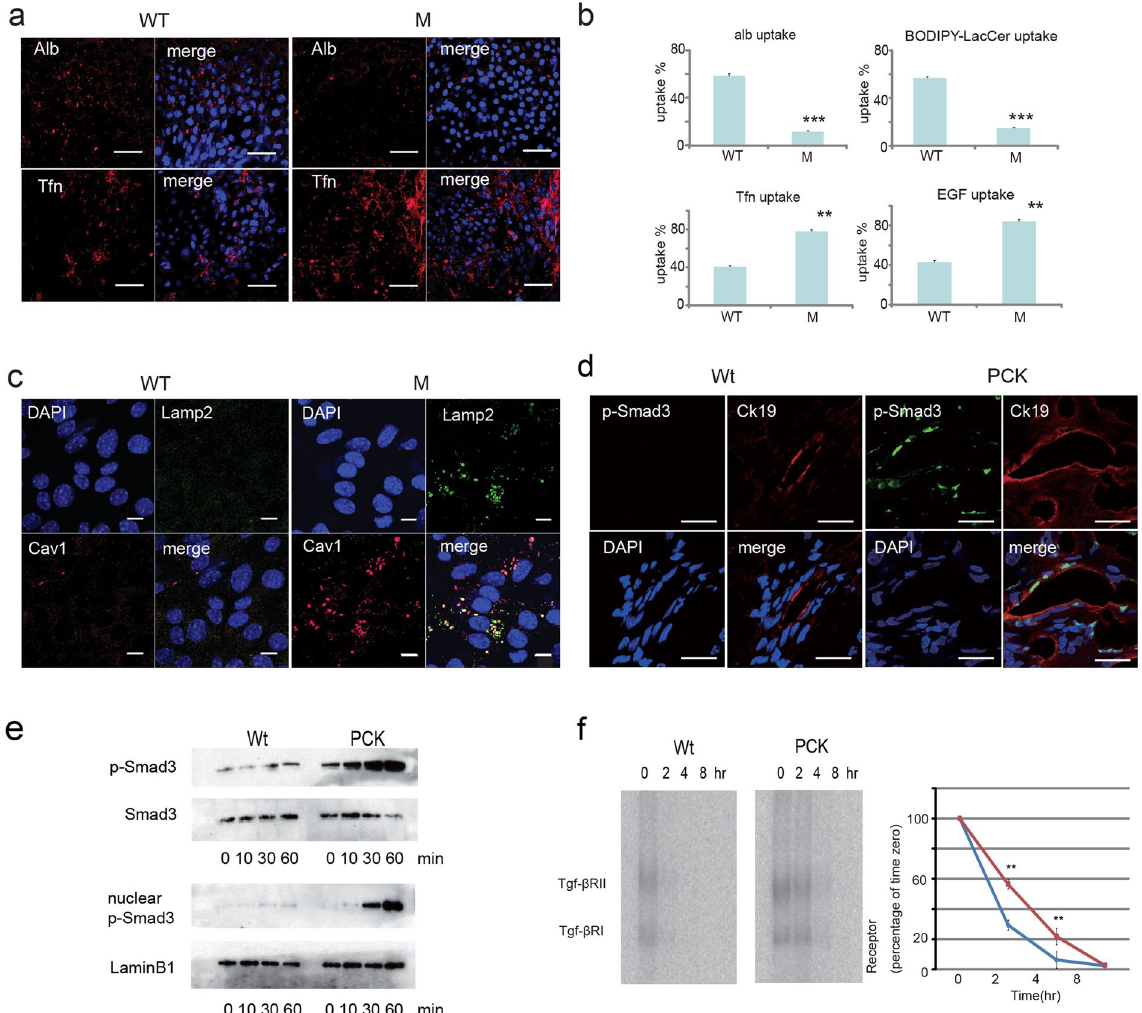
Figure 6. Pkhd1 del3-4/del3-4 collecting duct cells have abnormal endocytosis and membrane protein partition defects. ( a ) Endocytosis assays in primary confluent cultures of collecting duct cells isolated from control (WT) and Pkhd1 del3-4/del3-4 mouse kidneys (M) using fluorescently-labeled markers for the caveolar [albumin (Alb, red)] and clathrin [transferrin (Tfn, red)] endocytic pathways. Nuclei were stained with DAPI. Scale bars, 50 μ m. ( b ) Quantitation of results for internalization assays using fluorescent markers for the clathrin (Tfn, EGF) and caveolar (alb, LacCer) endocytic pathways in confluent primary cultures of collecting duct cells from control (WT) and Pkhd1 del3-4/del3-4 (M) mice. Data were obtained using conventional fluorescence and are expressed as percent of uptake. Data represent quantification of at least 100 cells from each of three independent experiments. ** P < 0.01, *** P < 0.001. ( c ) Primary confluent cultures of collecting duct cells isolated from control (WT) and Pkhd1 del3-4/del3-4 mouse kidneys (M) were stained for markers of lysosomes (Lamp2, green) and caveolin-1 containing lipid-raft rich vesicles [Cav1 (red)] and DAPI (blue). The merged image shows co- localization of caveolin-1 with Lamp2 in large, vacuole-like lysosomes in the mutant cells. Scale bars, 10 μ m. ( d ) Liver specimens of 12-week old Crj:CD/SD (Wt) (control) and PCK rats were stained for phospho-Smad3 (p-Smad 3, red), cytokeratin 19 (Ck19, red) and DAPI (blue). Scale bars, 20 μ m.( e ) Cell lysates of Crj:CD/SD (Wt) (control) and PCK mutant cholangiocyte cell lines treated with TGF- β for the indicated times and fractionated into cytoplasmic (top two panels) and nuclear (bottom two panels) fractions. Immunoblots were probed for phospho-Smad3 (p-Smad3) and total Smad3. Total Smad3 and LaminB1 were used as loading controls for the cytoplasmic and nuclear fractions, respectively. ( f ) Tgf- β receptor degradation assay in rat cholangiocyte cell lines. On the left, autoradiographs of a representative experiment for Crj:CD/SD (Wt) (control) and PCK mutant cholangiocyte cell lines treated with [125I]-labeled human TGF- β and then analyzed for levels of labeled Tgf- β receptor subunits at the times indicated. Three separate experiments were carried out, quantified by phosphorimaging and graphed as receptor quantity (% of time 0) vs. time (graph on right). Each point represents the mean ± SD. The results for wild type are in blue and mutant in red. ** P < 0.01. The full- length blots of cropped images in e and f are included in Supplementary Fig.